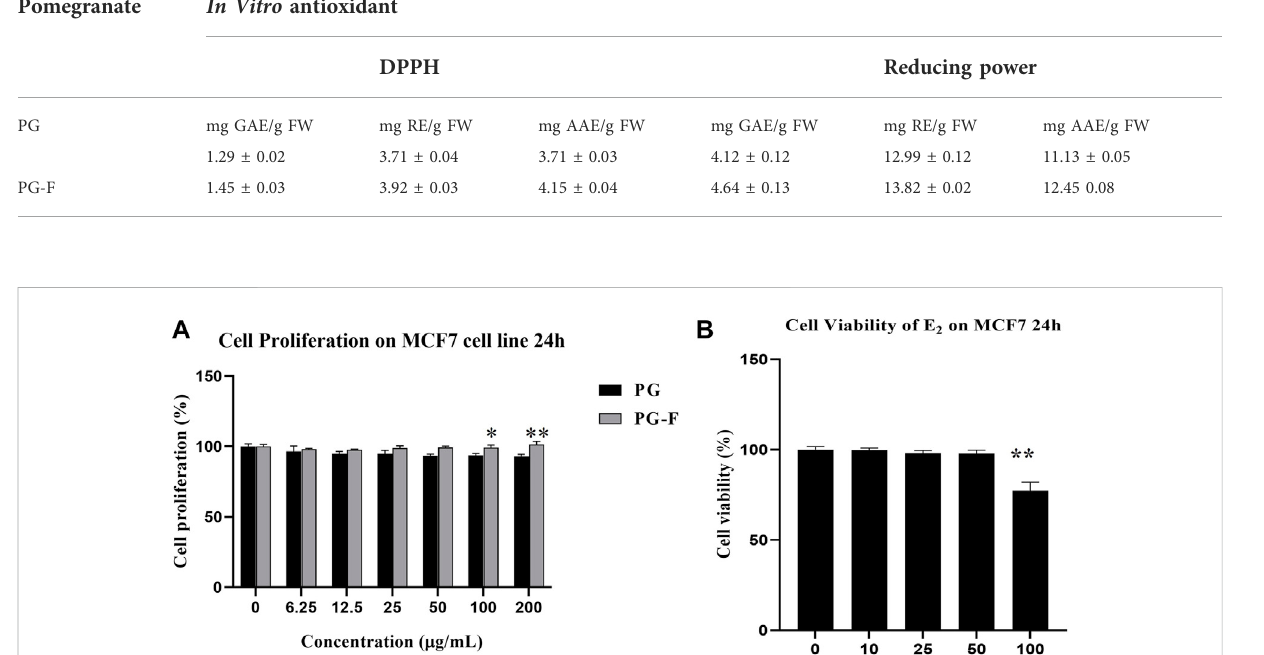
TABLE 4 Potential antioxidant activities of Pomegranate.